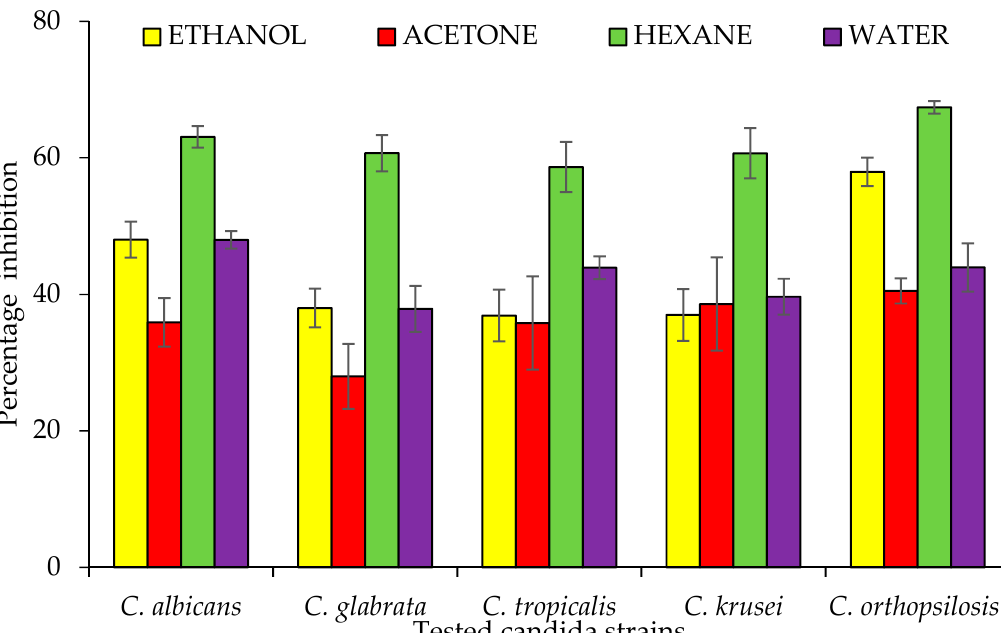
Figure 2. Anticandida activity of different extracts of Bidens bipinnata ; positive control fluconazole.